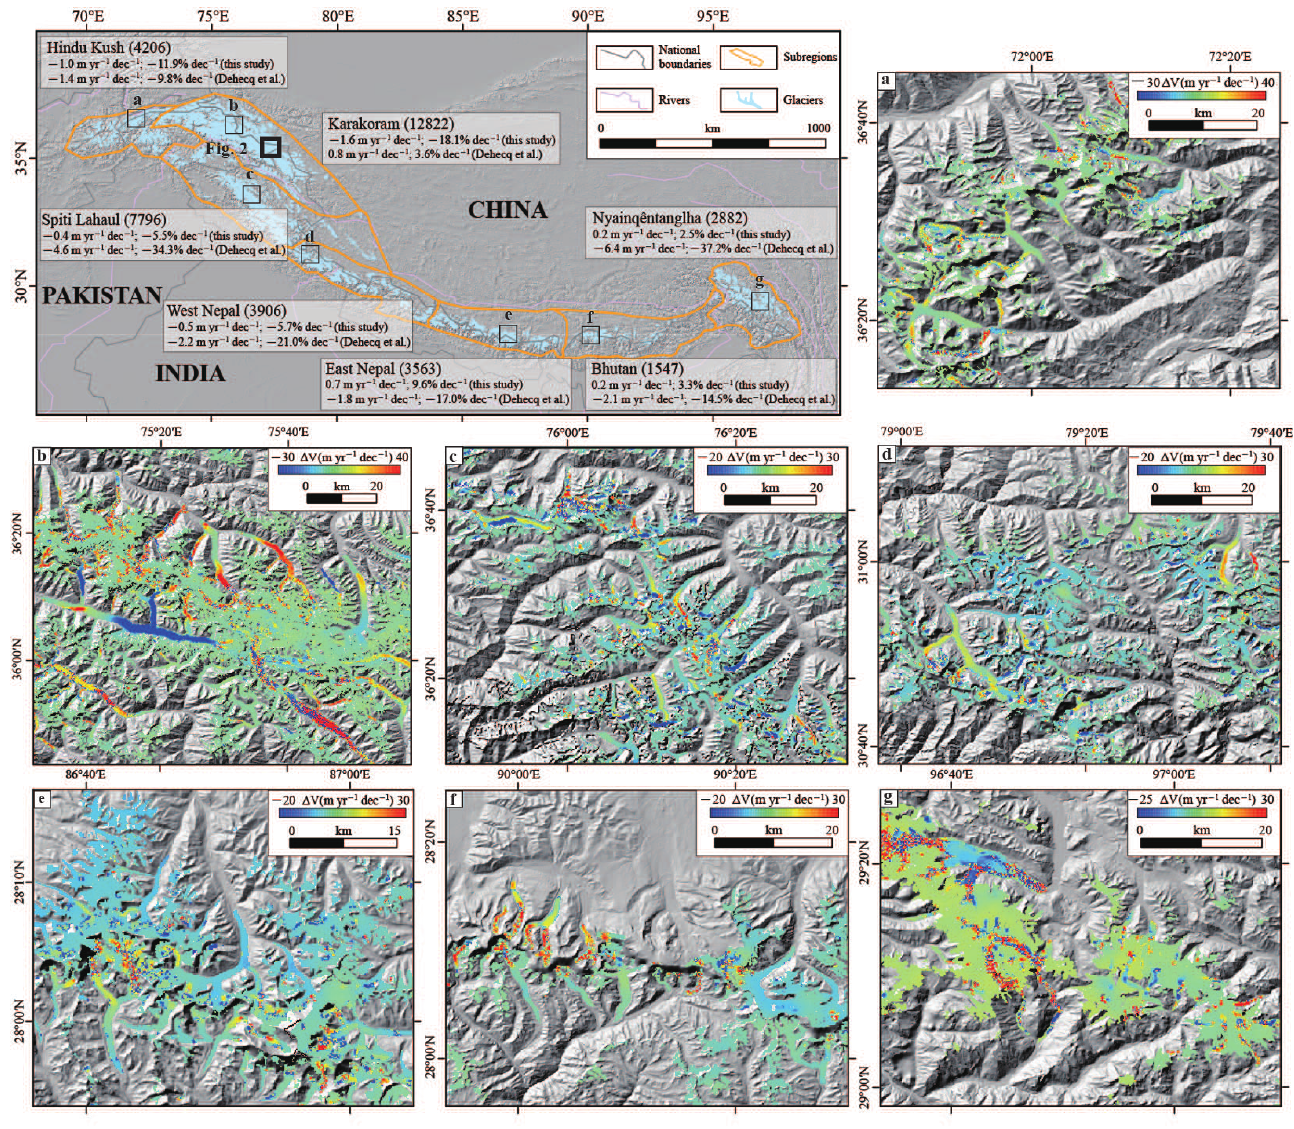
Figure 1. Glaciers are highlighted in light blue. The total number of glaciers in each subregion is labelled. Black box marks the location of Figure 2. We calculated the mean value of velocity changes of each subregion and compared our estimates to [9]. ( a – g ) shows examples of velocity changes in subregions. See Table 1 for